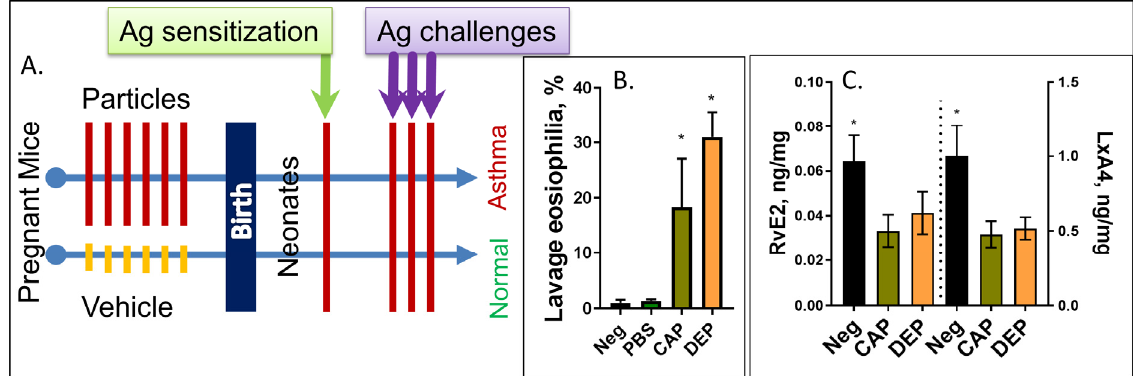
Figure 1. Schematic of the study protocol. ( A ) Pregnant dams at E14-E20 days of gestation received 6 intranasal instillations of CAP or DEP suspensions, or vehicle. After birth, the pups received a single i.p. sensitization injection with ovalbumin OVA at postnatal day P3 and a set of 3 OVA aerosol challenges at days P12-14, and were then analyzed at P16. Pups born to particle-exposed mothers but not control mothers developed asthma phenotype seen as eosinophilic AI ( B ) and other asthma-like features (airway hyperresponsiveness, lung tissue infiltration, and cytokine increases (not shown, see [26–31])); (n) = 12, and * p < 0.05. ( C ) Lipidomic profiling of the neonate lungs shows decreased levels of LxA4 and RvE2 in pups of CAP or DEP exposed mothers but not controls (reanalysis from [43]); (n) = 9, and * p < 0.05.